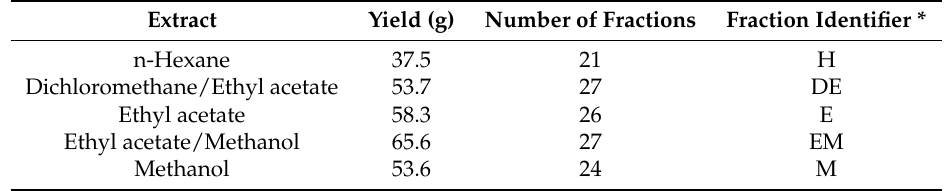
Table 1. Crude extracts and fractions obtained from C. telenitida roots by chemical fractionation. Extract Yield